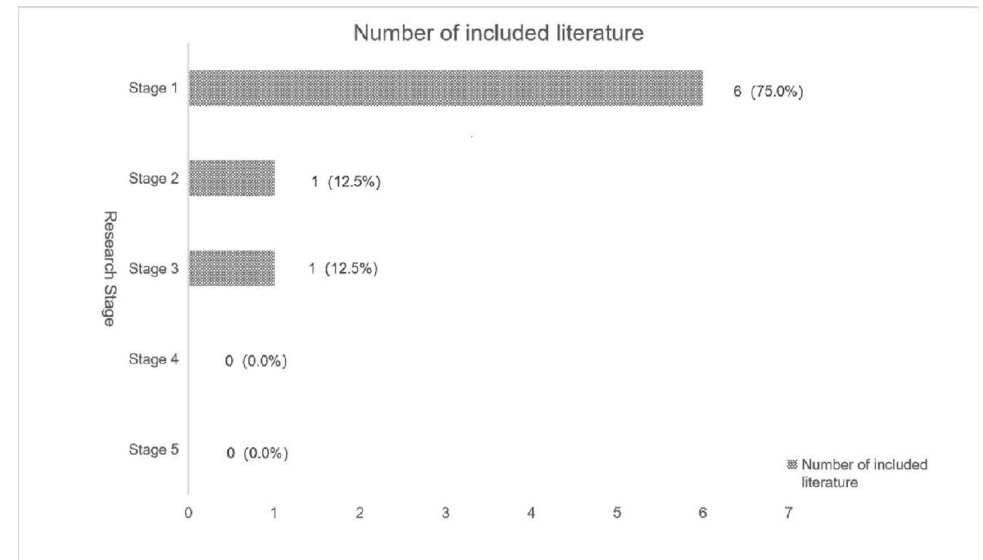
Figure 2. Distribution of SB study topics in young and middle-aged adults with hypertension (stage 1: studies to explore and verify the association between SB and health; stage 2: studies on SB meas- urement methods; stage 3: studies to explore the factors influencing SB; stage 4: studies on interven- tion strategies for SB; stage 5: studies on the practical application of intervention strategies).